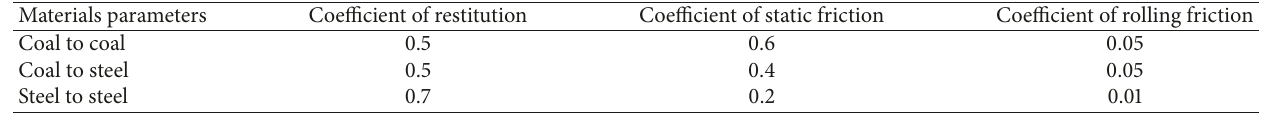
Table 2: The parameters of contact properties of coal and steel.